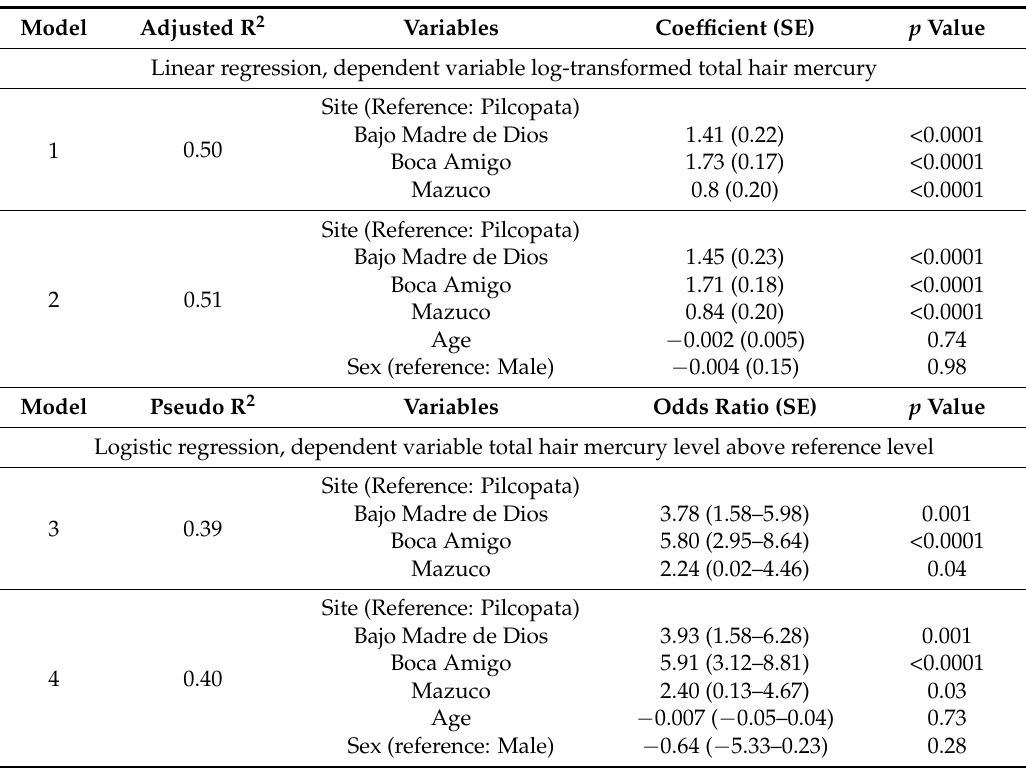
Table 5. Results of multivariable linear and logistic regression models evaluating differences in total hair mercury at four study sites in the Madre de Dios river basin of Southeastern